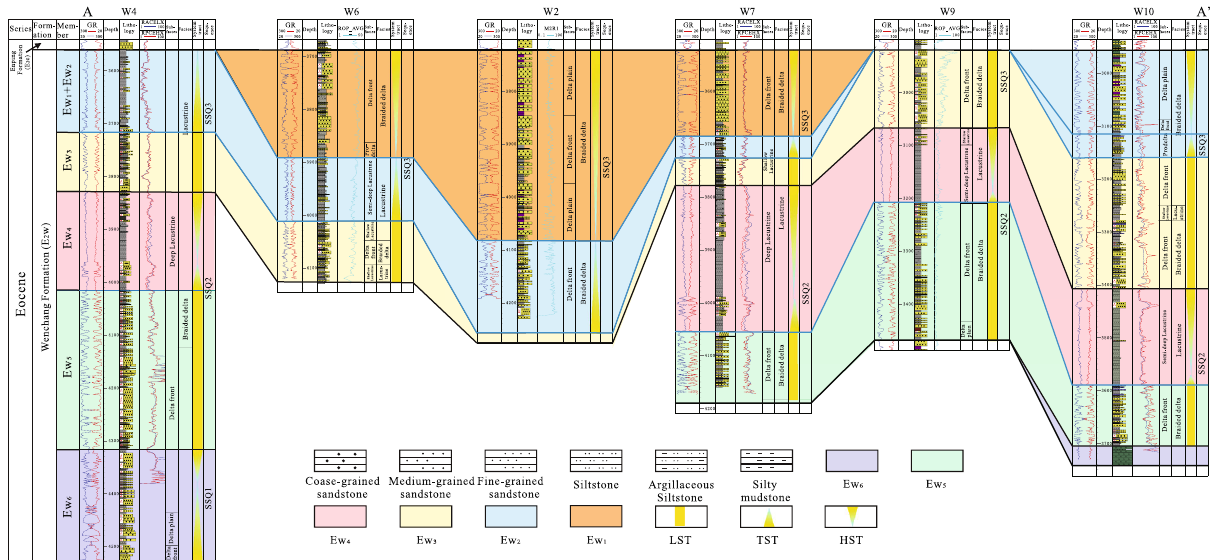
Figure 3: Regional stratigraphic correlation pro fi le AA ’ of E w, and the location of the pro fi le AA ’ is given in Figure 1(b). The di ff erent 2 w. It also shows the sequence classi fi cation and depositional facies according to the logging colors represent di ff erent members of E 2 facies and lithological association.